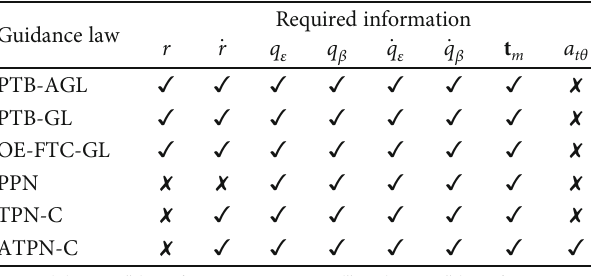
Table 1: Required information of guidance